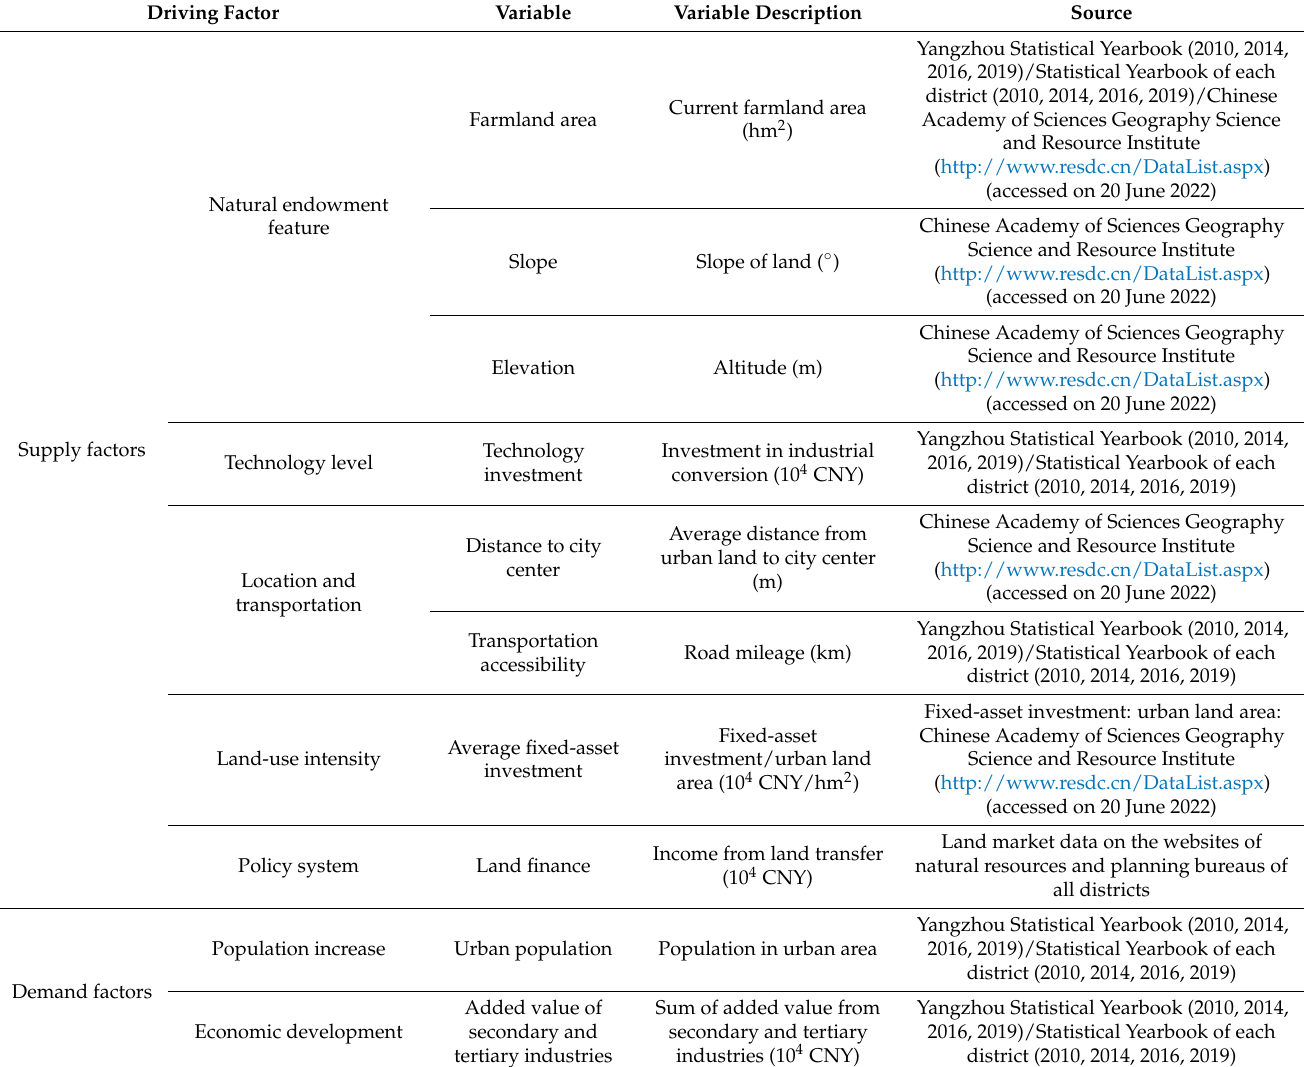
Table 1. The driving factors of urban land